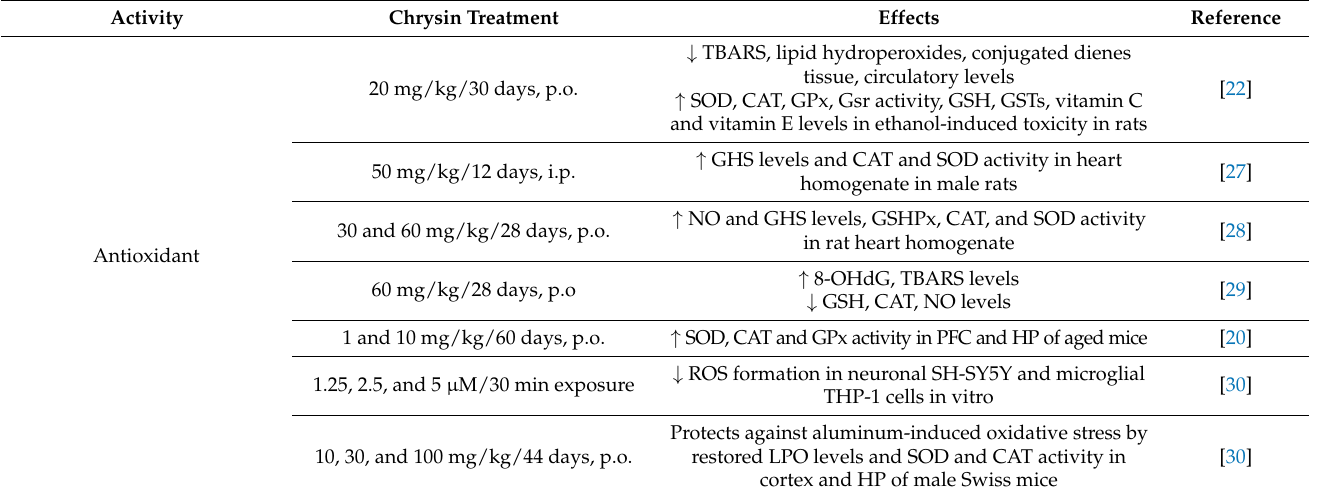
Table 1. Some neurochemical effects produced by flavonoid chrysin potentially involved in its anxiolytic- and antidepressant-like